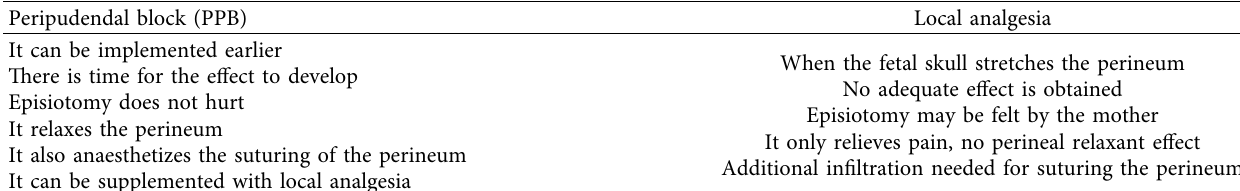
Table 4: Comparison of the peripudendal block with the perineal infiltration. Peripudendal block (PPB)